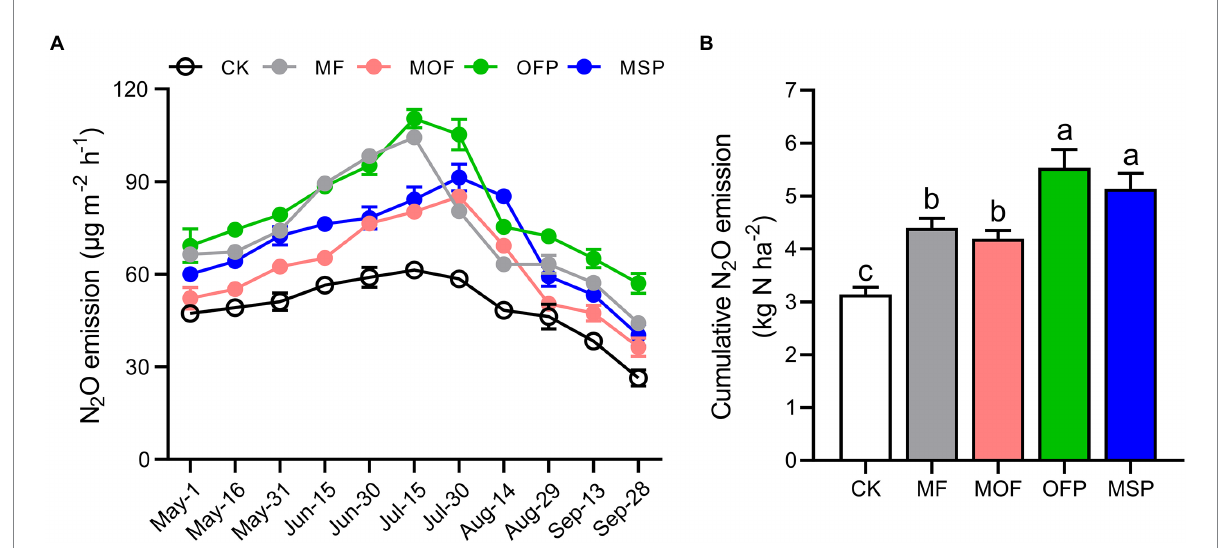
FIGURE 2 The changes in N 2 O emission flux (A) and cumulative N 2 O emission (B) among different fertilization treatments. Bars ( n = 3) with different lowercase letters indicate significant differences based on Tukey’s HSD test ( p < 0.05). CK, No fertilization; MF, mineral fertilizer; MOF, mineral fertilizer plus commercial organic fertilizer; OFP, commercial organic fertilizer; MSP, maize straw.